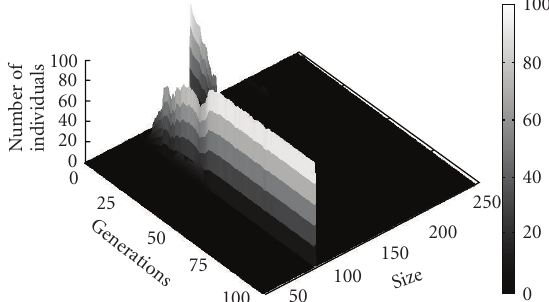
Figure 12: Symbolic regression Experiment 4: chromosome size in the population.